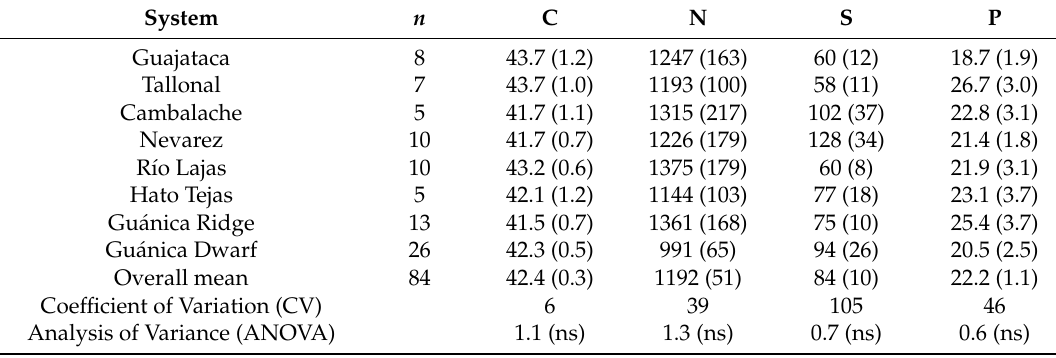
Table 3. Mean ( ± SE) concentrations of main elements of organic matter C in mol/kg, the rest in mmol/kg.